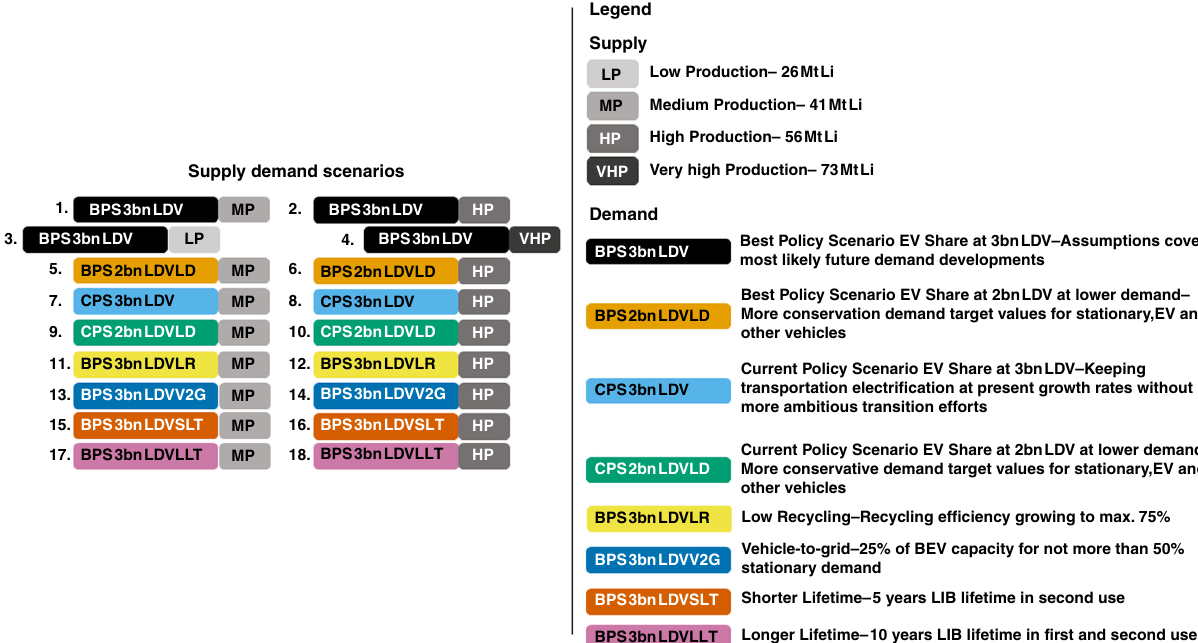
Fig. 2 Scenario table. Listing and description of this study ’ s supply and demand scenarios. In total, there are 18 pairs that consist of one demand element and one comparative supply element each. Two Best Policy Scenarios (1., 2.) are the groundwork for 16 subsequent deviations, which cover the fi ve most important in fl uencing factors (supply, EV uptake policy, recycling, V2G and battery lifetime). The high supply uncertainty requires two base supply scenarios. The legend describes the individual components of this modular system.